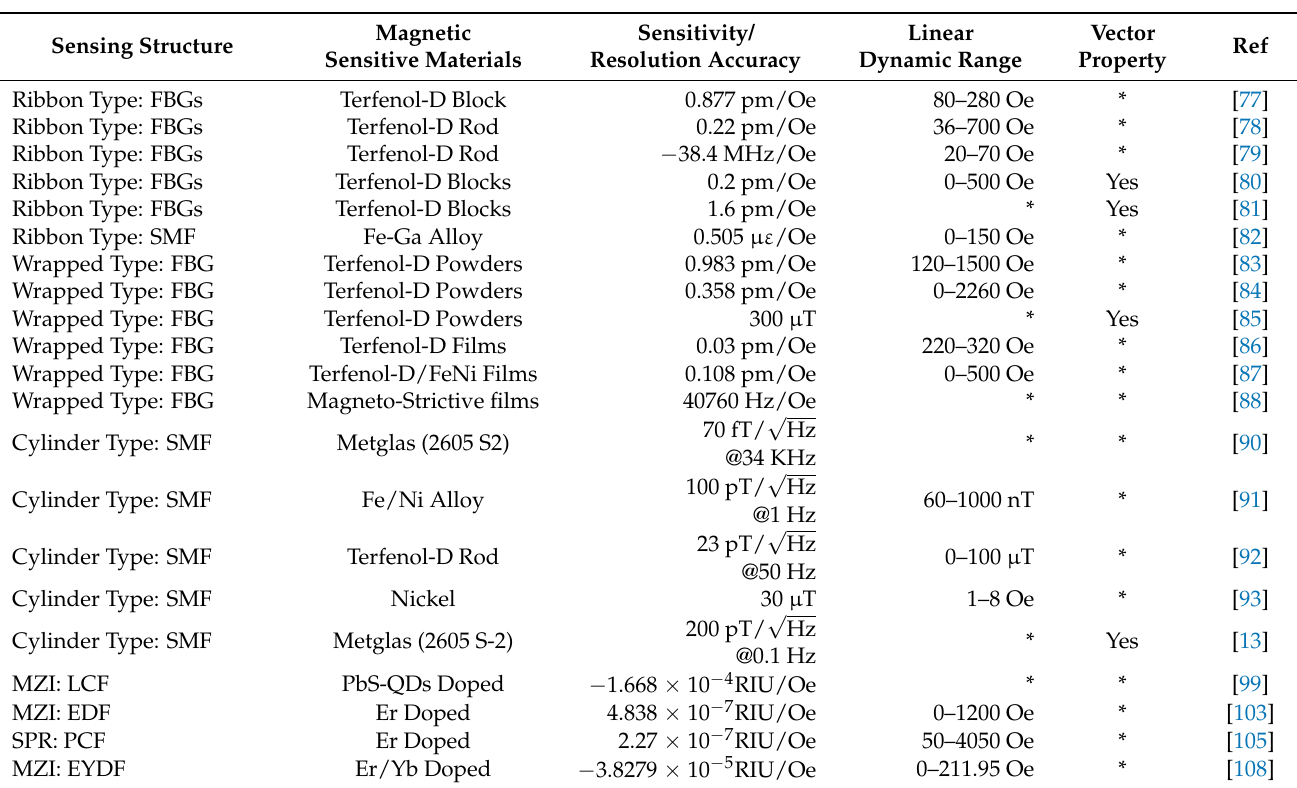
Table A2. Main performance parameters of magnetic field fiber sensors based on